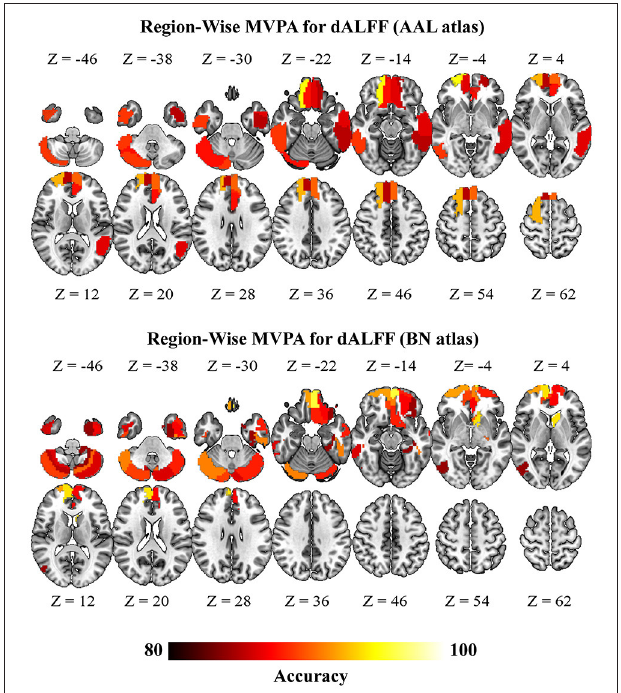
FIGURE 6 | Brain regions with significant correlation coefficients in the prediction of JOA recovery rate using the static amplitude of low-frequency fluctuation (sALFF) ( p < 0.05, FWE for multiple comparison correction). DCM, Degenerative Cervical Myelopathy; HC, Healthy Controls; AAL, Anatomical Automatic Labeling; BN,